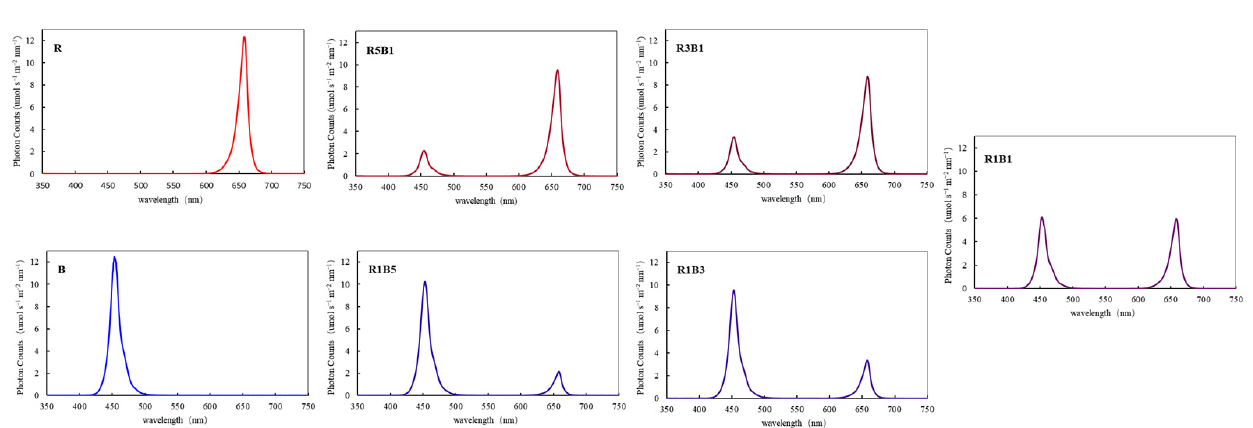
Figure A1. The spectra treated with different proportions of red and blue are shown in the figure. R: monochromatic red light; R1B5: red to blue ratio = 1:5; R1B3: red to blue ratio = 1:3; R1B1: red to blue ratio = 1:1; R1B3: red to blue ratio = 1:3; R1B5: red to blue ratio = 1:5; B: monochromatic blue light. Table A1. The power under different proportions of red and blue treatments is shown in the table. R: monochromatic red light; R1B5: red to blue ratio = 1:5; R1B3: red to blue ratio = 1:3; R1B1: red to blue ratio = 1:1; R1B3: red to blue ratio = 1:3; R1B5: red to blue ratio = 1:5; B: monochromatic blue light.